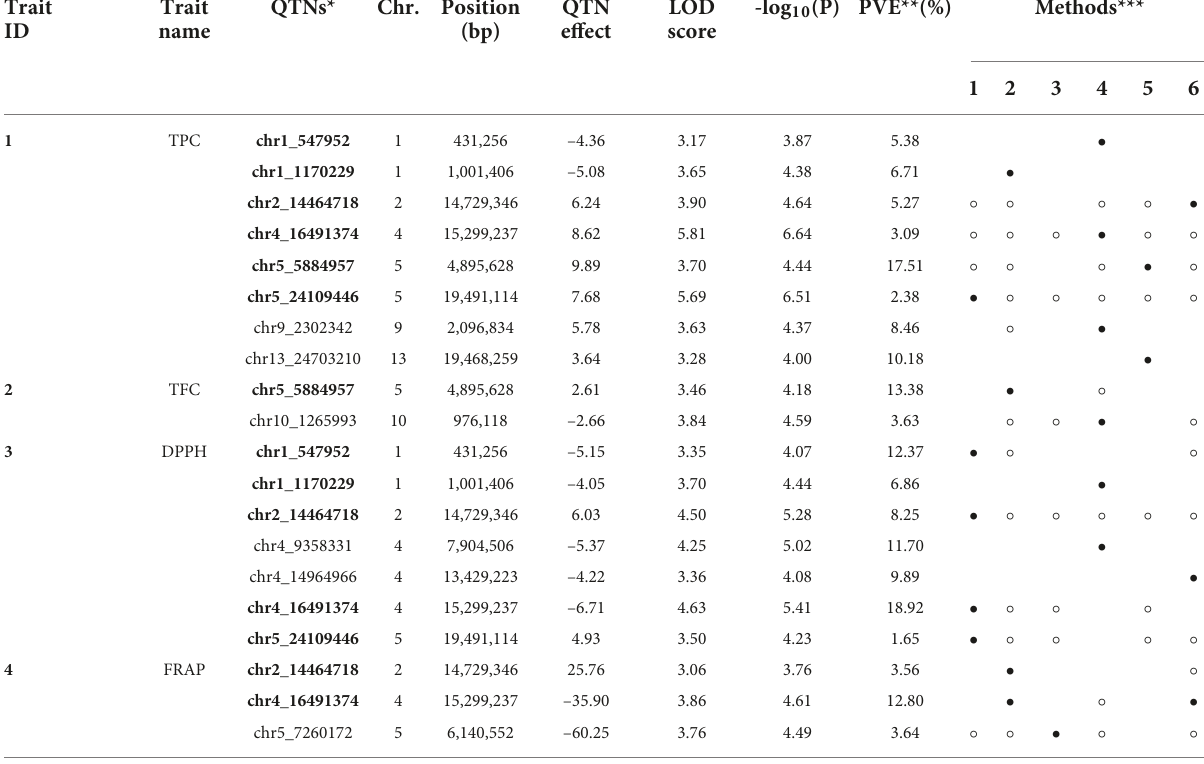
TABLE 2 List of significant QTNs for the traits identified by the six multi-locus GWAS. Trait